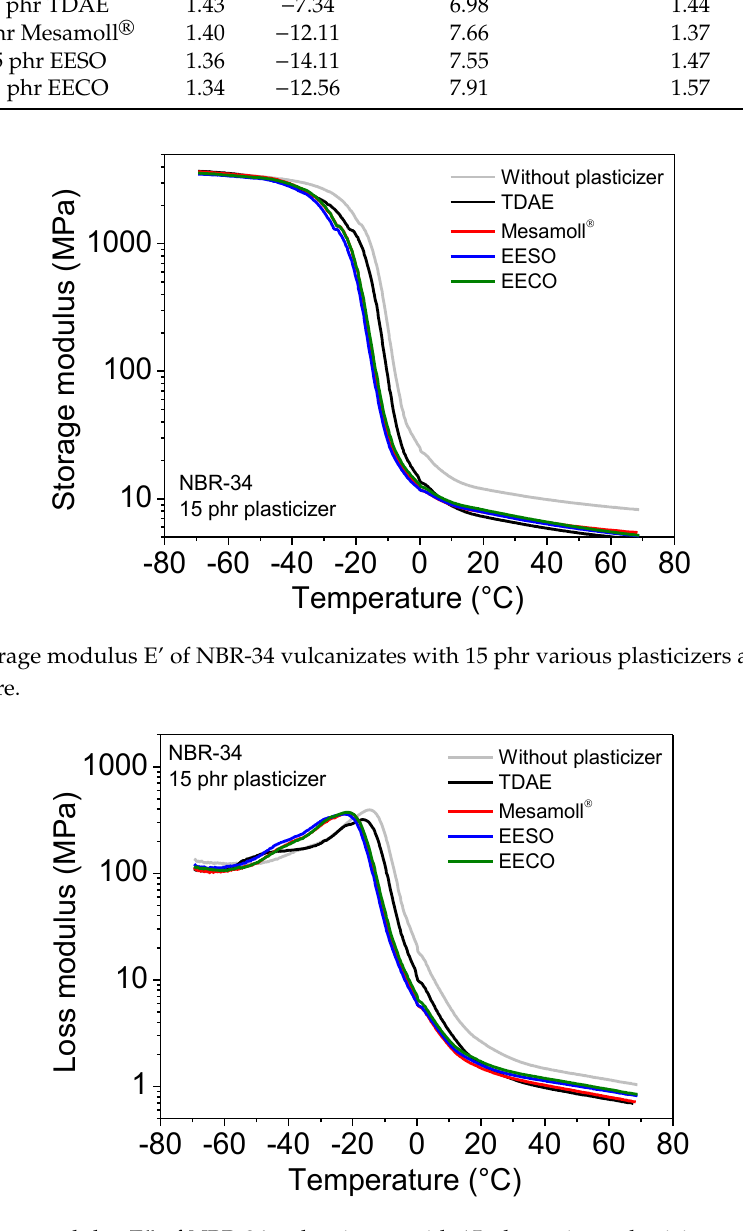
Figure 10. Loss modulus E” of NBR-34 vulcanizates with 15 phr various plasticizers as a function of temperature.